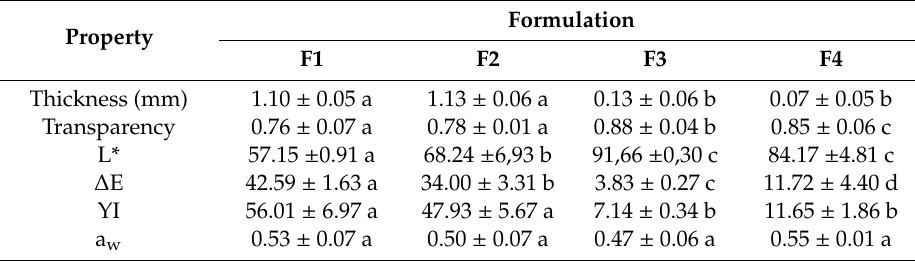
Table 2. Characteristics of the films obtained for di ff erent formulations of guar gum and isolated soy